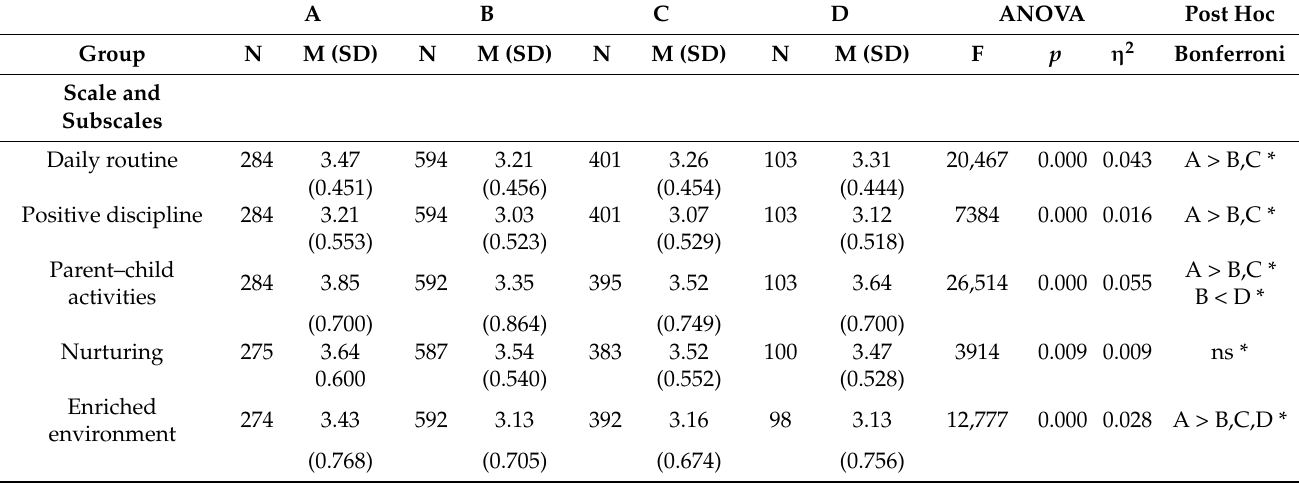
Table 2. Descriptive statistics and analyses of variance for the daily routine scale and its subscale according to the parents’ employment